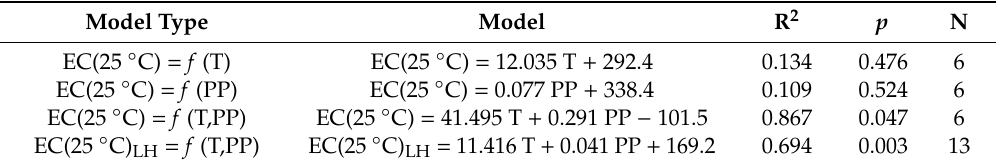
Table 4. Climatic models for estimation of multiannual changes of mean surface water conductivity of all SLP lakes (EC) and Lake Ha´ncza (EC LH ). Explanations: T—Average annual temperature ( ◦ C), PP—Total annual precipitation